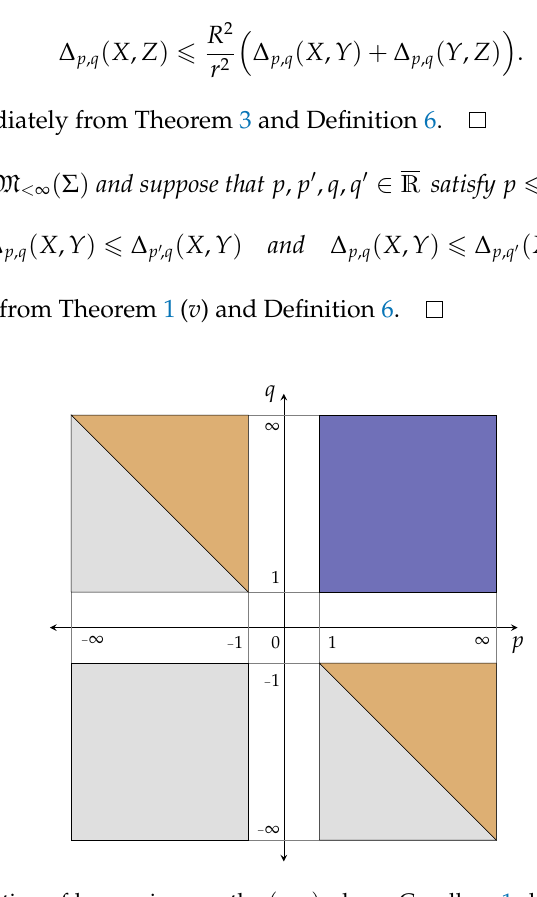
Figure 2. Representation of key regions on the ( p , q ) -plane. Corollary 1 shows that ∆ p , q is a proper metric in the violet region and Corollary 2 shows that it is an inframetric in the orange and light-gray ones. Numerical evidence suggests that ∆ p , q is still a proper metric in the orange